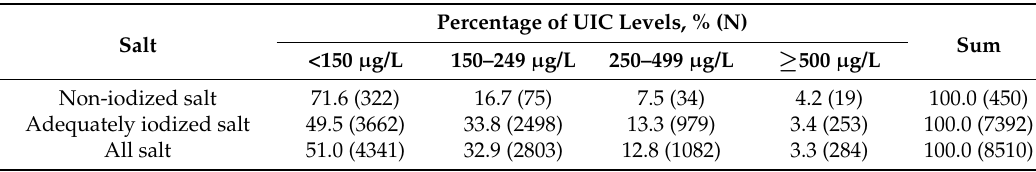
Table 5. Percentage of UIC in pregnant women consuming different